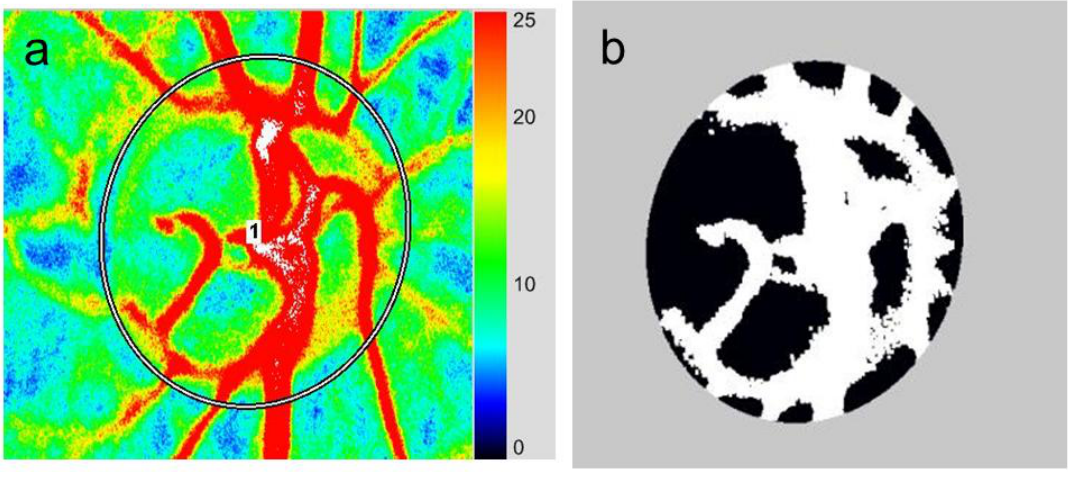
Figure 5. Assessment of blood flow within the optic nerve head (ONH). ( a ) The margin of the ONH is identified using a round band according to the color photograph of the